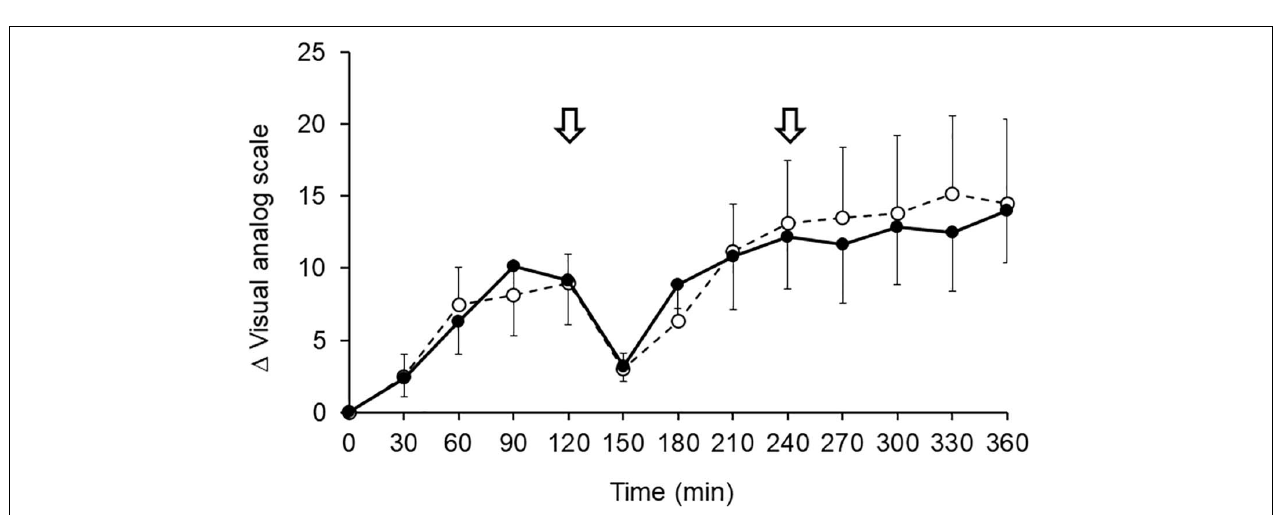
FIGURE 5 | Comparison of skin temperature in the lower leg after 1,000 mg of G-Hsp ( upper panel ) and Placebo (lower panel) beverage ingestion in a subject.